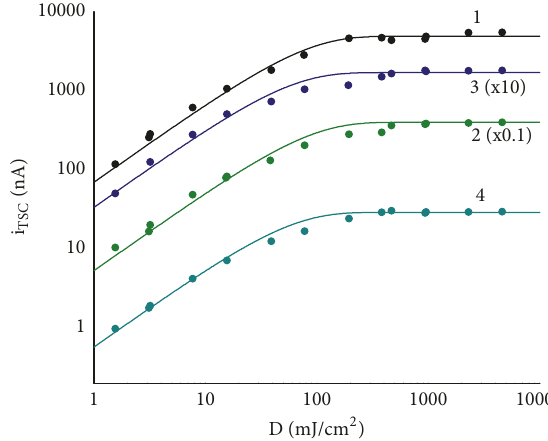
Figure 5: Dose dependencies of TSC peaks of ZnSe (#2) 𝑇 m = 143 K (1) , 170 K (2) , 183 K (3) , and 224 K (4) with U 0 = 15 V (dots) and theoreticalcurvesofthelightsumaccumulation(solidlines)by (10) .